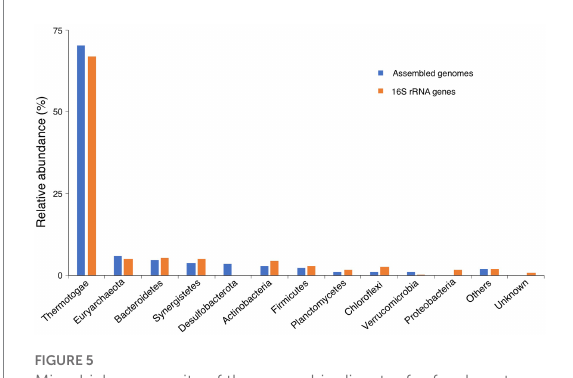
FIGURE 5 Microbial community of the anaerobic digester for food waste. The microbial community derived from the assembled genomes was generated based on the taxonomic annotation of the whole genomes by using GTDB-Tk, while that derived from the 16S rRNA genes was obtained from the taxonomic annotation of the full-length 16S rRNA genes identified from the HiFi reads, using the tool RDP